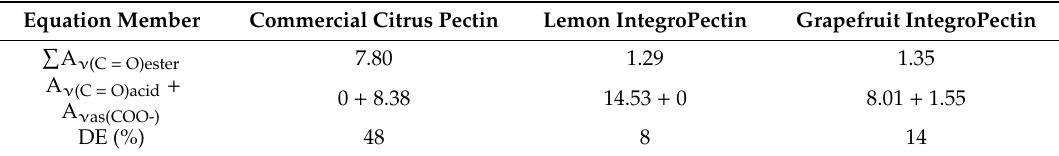
Table 1. Degree of esterification (DE) for both lemon and grapefruit